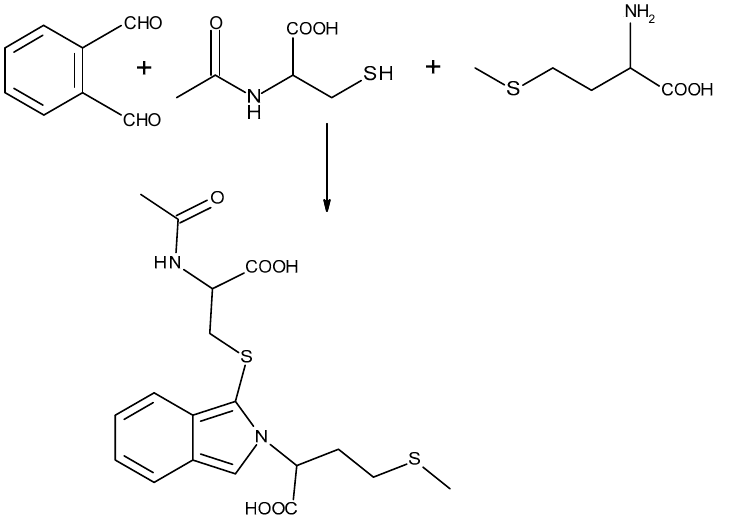
Figure 6. The scheme of chemical derivatization reaction of methionine with o -phthaldialdehyde and N-acetylcysteine.